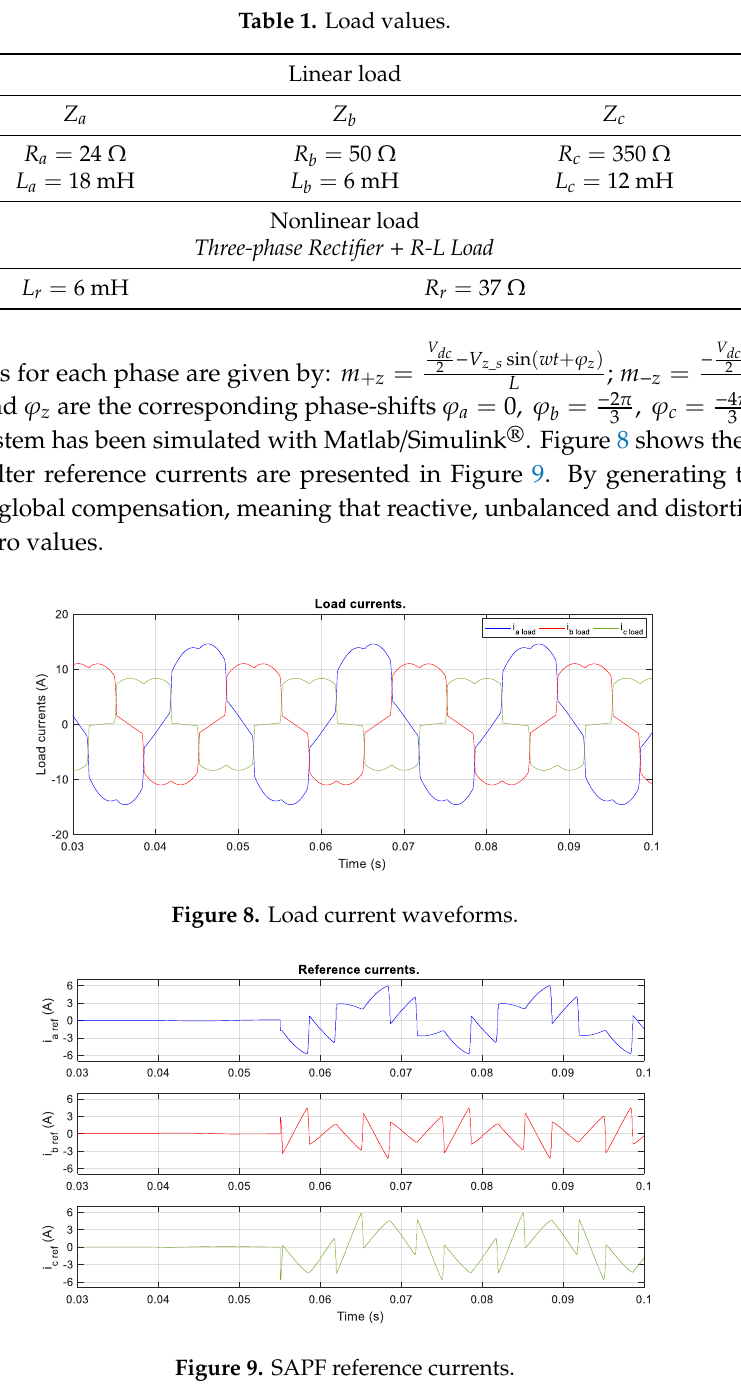
Figure 10. Current tracking performance for phase a . Figure 11. Current tracking performance for phase a . Detail 1 (0.06 s < t < 0.08 s). Figure 12. Current tracking performance for phase a . Detail 2 (0.068 s < t < 0.0725 s).